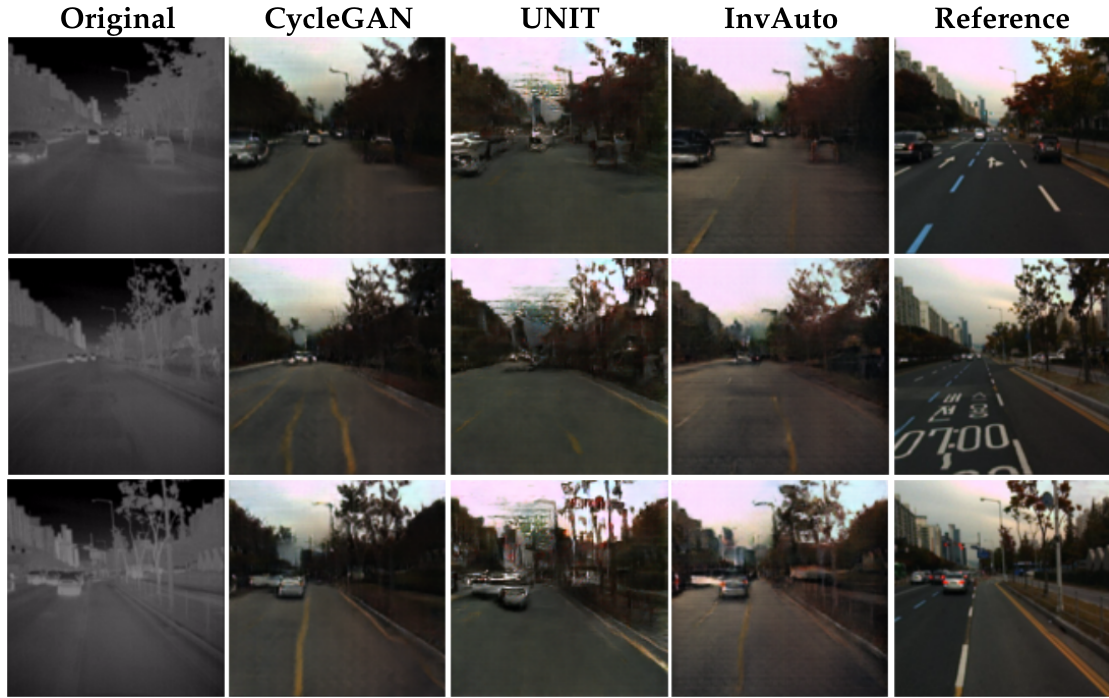
Figure A8. Thermal-to-day image